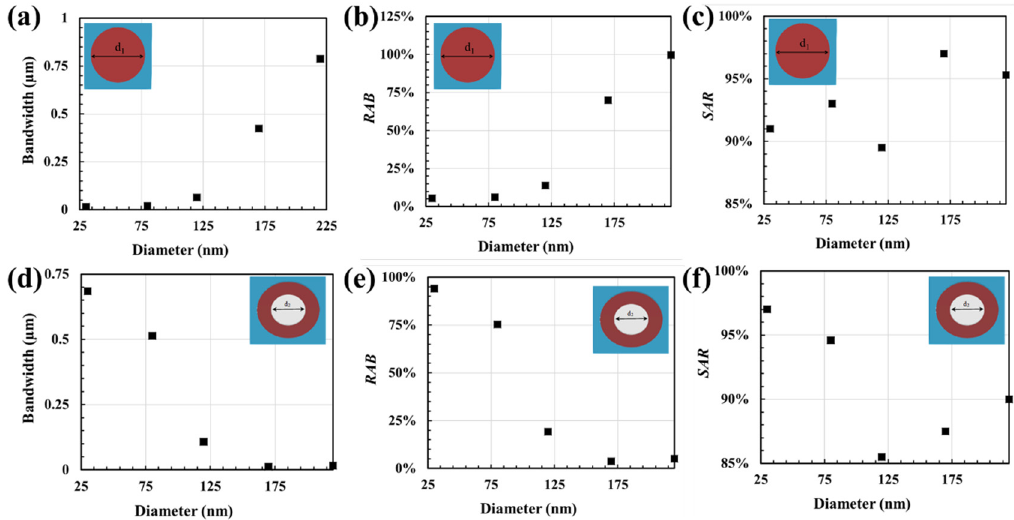
Figure 4. Absorption properties of the metamaterial absorber structure with various cap array ( a , d ) Bandwidth, ( b , e ) RAB, and ( c , f ) SAR. ( a , d ) Bandwidth, ( b , e ) RAB, and ( c , f )